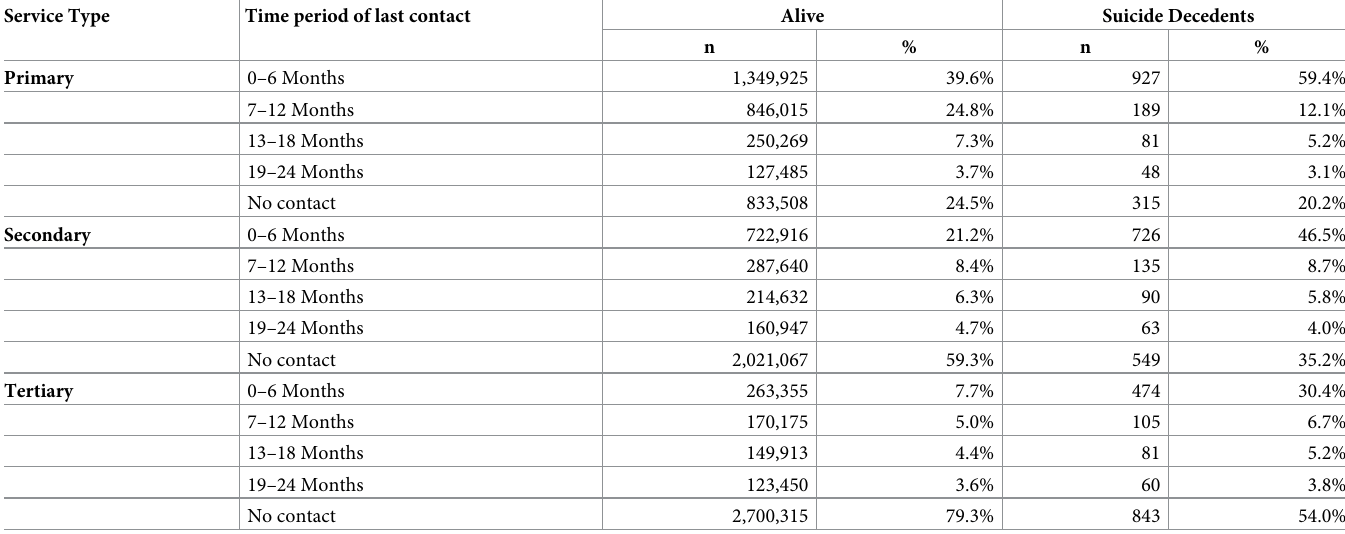
Table 1. Timing of last contact for suicide decedents and individuals alive at the end of the study period. Service